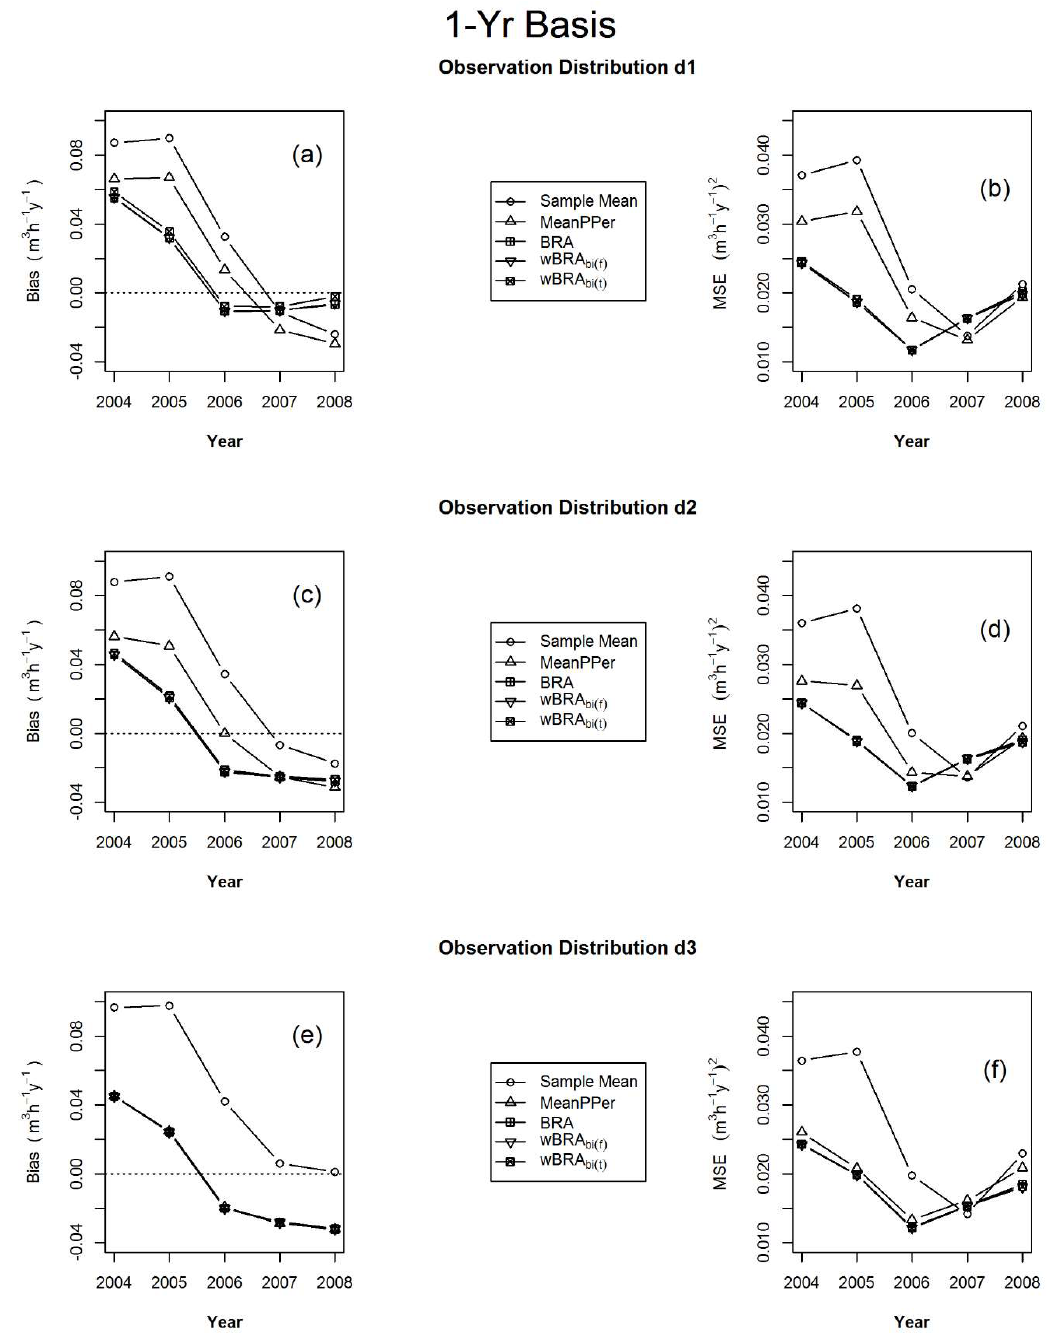
Figure 6. The simulation mean bias in the left graphs ( a , c , and e ) and the simulation mean of mean-squared errors in the right graphs ( b , d , and f ) for Estimand 1 (with a one-year basis), for each distribution d1 through d3, from top to bottom, respectively. These summary statistics were compiled after 100 iterations of composite samples of size 1000, for each of five sample observation lengths, within each of the 125 populations.